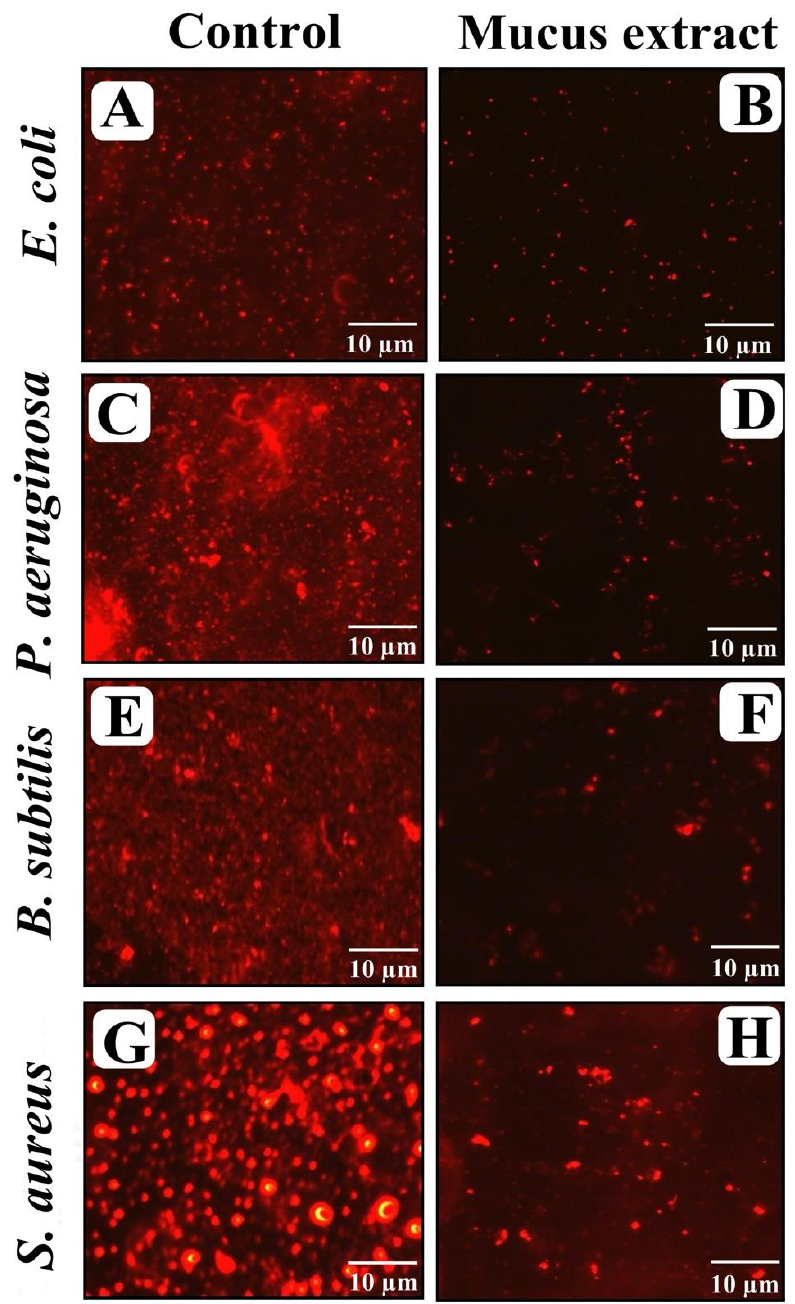
Figure 7. Micrographs of disrupted matured biofilms of tested strains formed on glass surfaces by P. sophore mucus extract at their respective MICs under fluorescent microscopy. ( A , C , E , G ) Growth control, ( B , D , F , H ) P. sophore mucus extract.